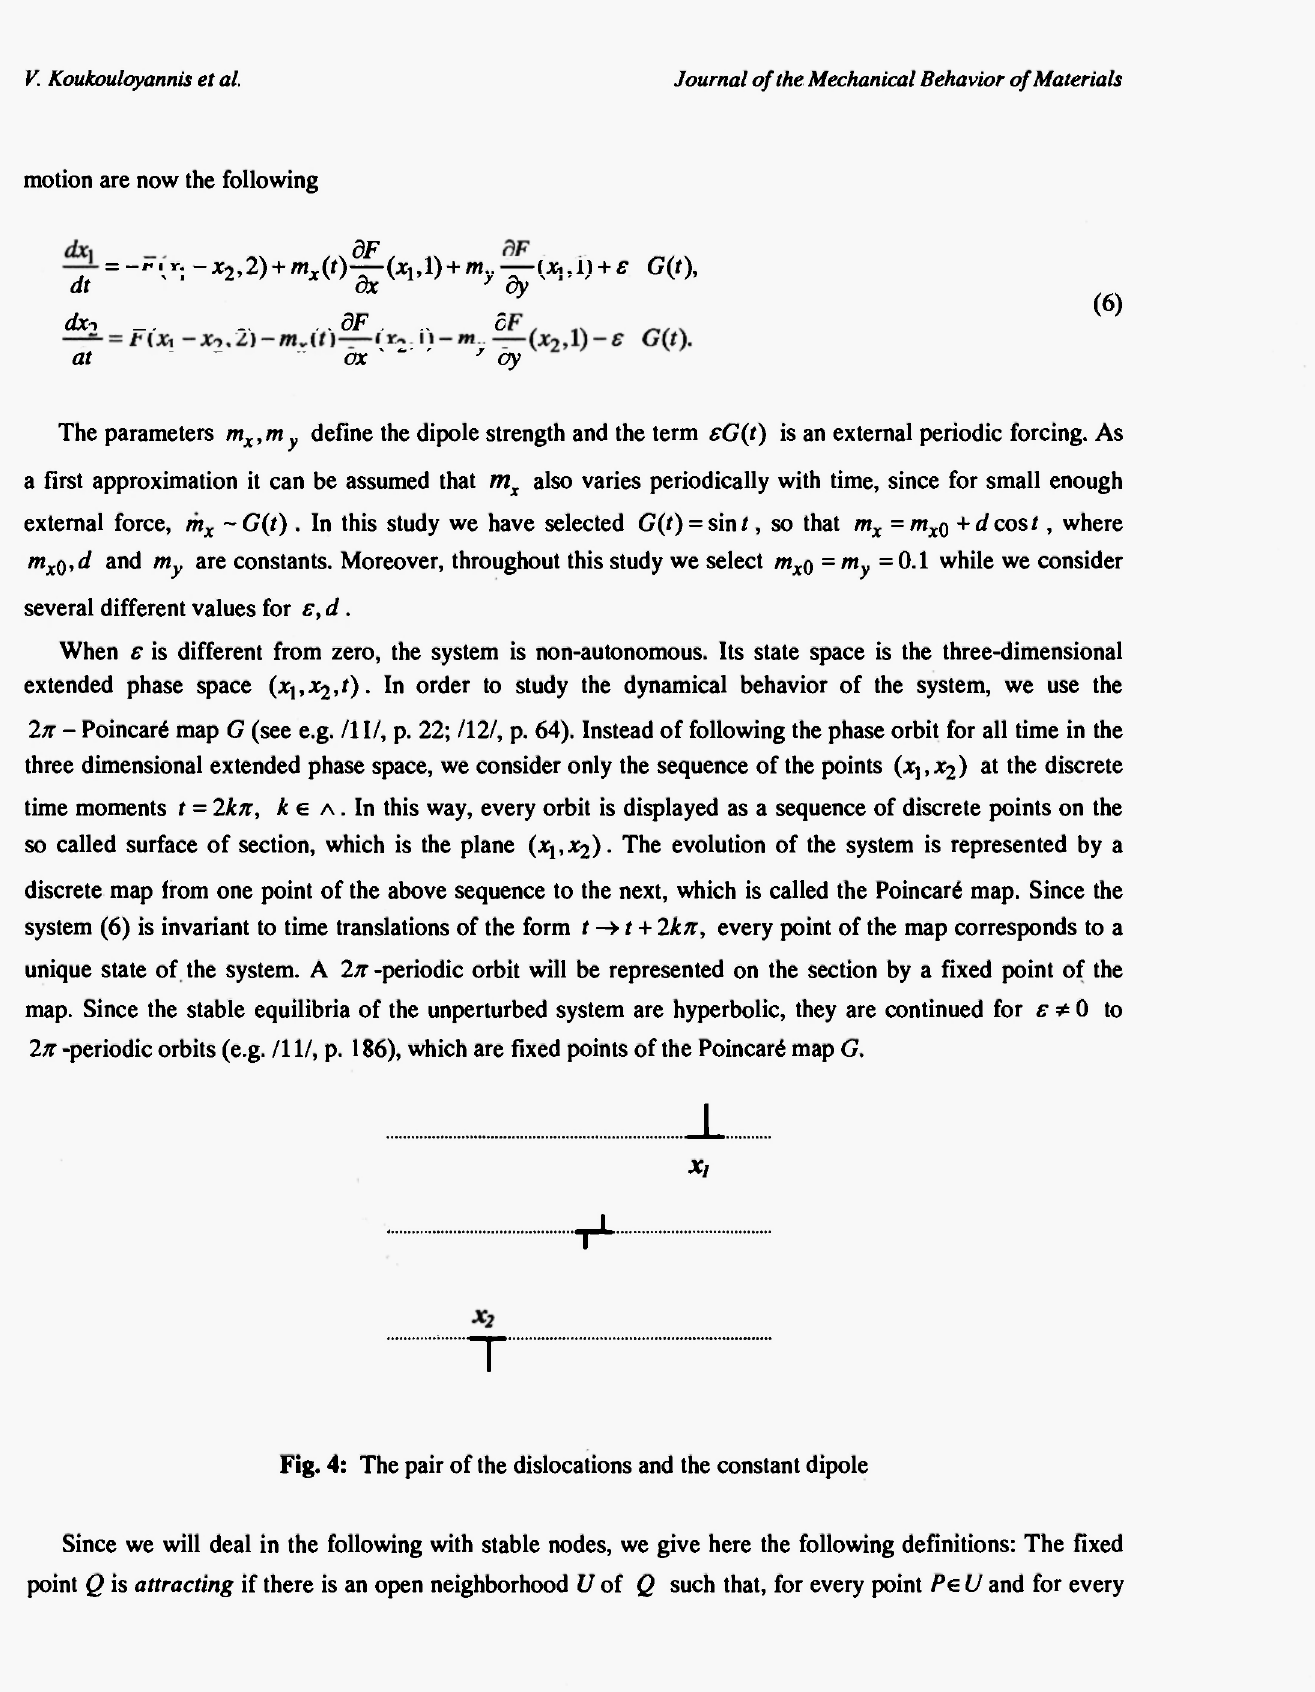
Fig. 4: The pair of the dislocations and the constant